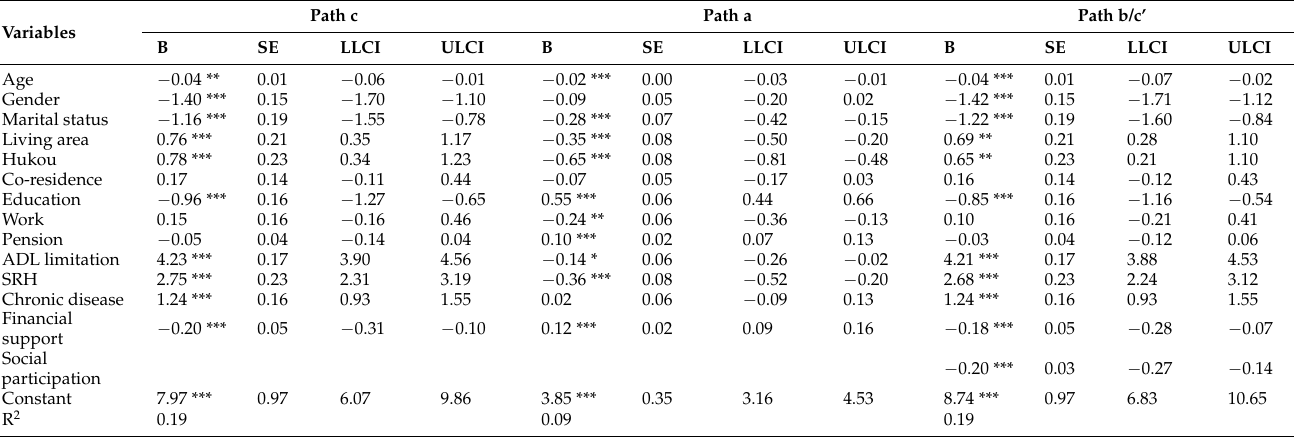
Table 3. Cross-sectional mediating effect of social participation in the association between financial support and depressive